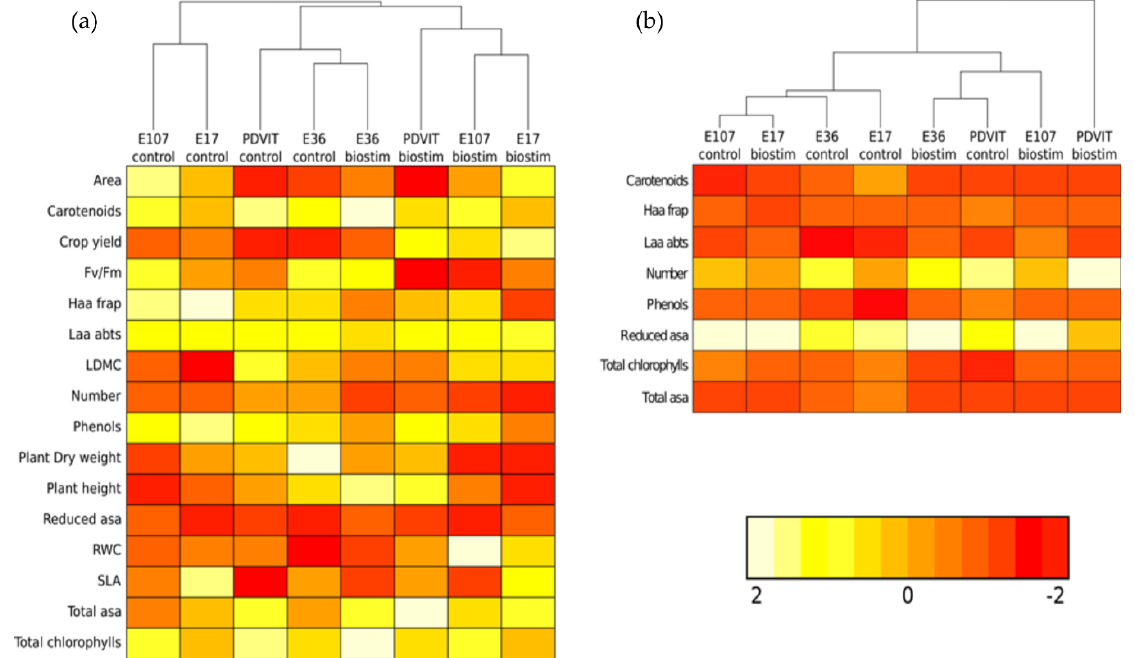
Figure 3. Cluster heat map analysis summarizing the behavior of the different tomato genotypes E36, E17, E107, PDVIT treated or non-treated with the biostimulant CycoFlow in leaf (panel a ) and in fruit (panel b ). The heat map was generated using the R environment for statistical computing and graphics (https://www.R-project.org/online) program package with Euclidean distance as the similarity measure and hierarchical clustering with complete linkage.